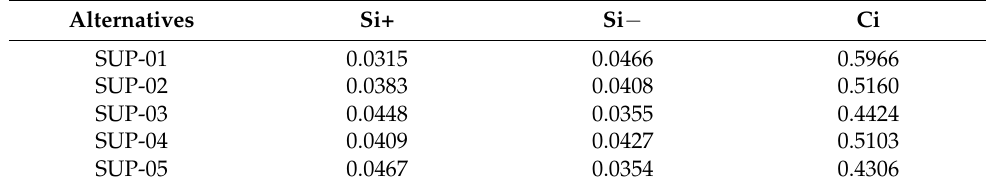
Table 5. Ci value from